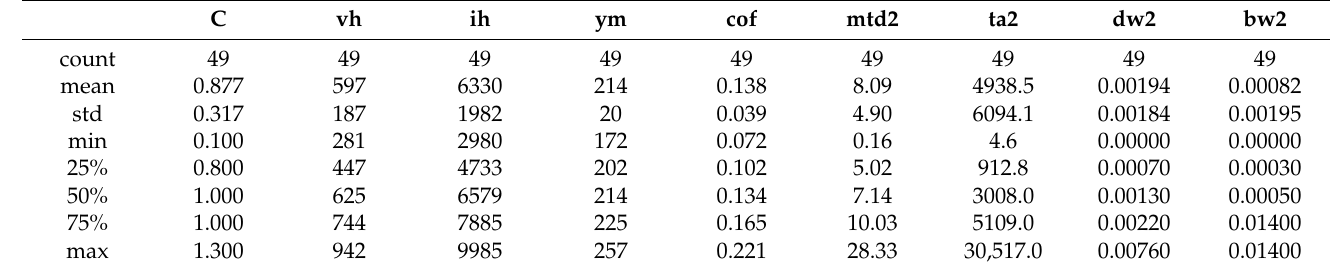
Table 7. Basic information for the set—fluid